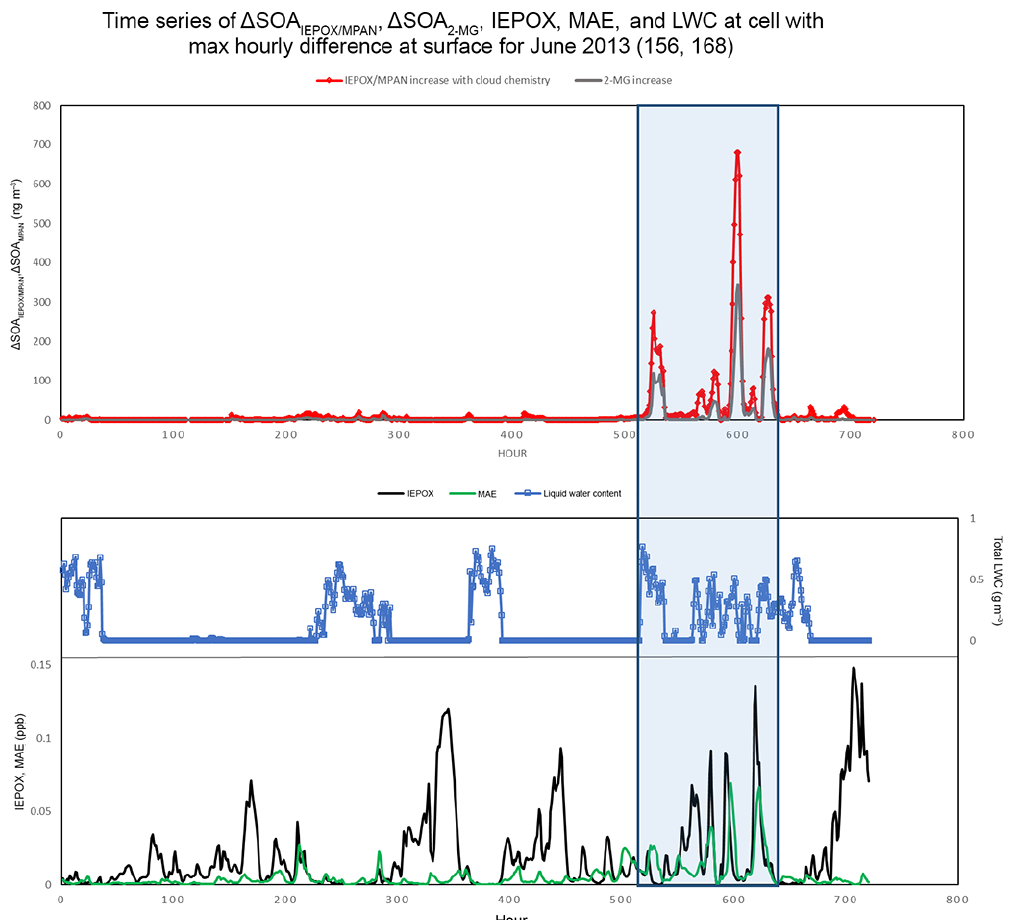
Figure 11. Change in SOA IEPOX/MPAN due to in-cloud production (alongside precursor and liquid water content levels) for the cell contain- ing the highest hourly difference during June 2013. Shown from top to bottom are (top) the change in predicted hourly concentrations of total SOA IEPOX/MPAN (ngm − 3 ) (red) and 2-MG (ngm − 3 ) (grey) with the additional in-cloud SOA production, (middle) cell liquid water content (gm − 3 ) (blue), and (bottom) IEPOX (ppb) (black) and MAE (ppb) (green) concentrations. Between 500 and 650h, on average, more than 40% of the additional SOA was